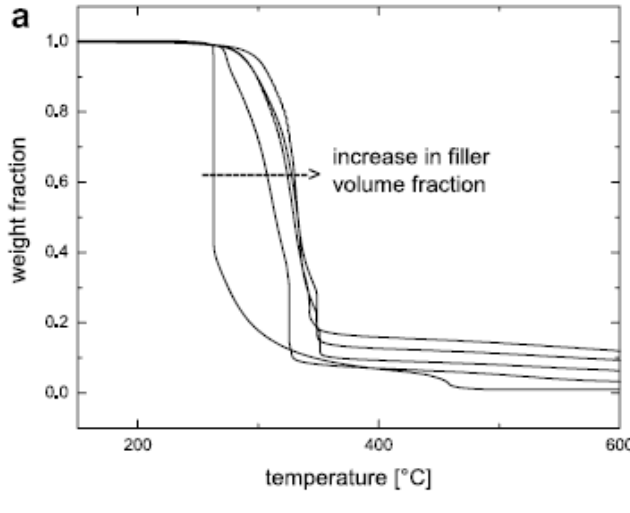
Figure 44. TGA thermograms of the polypropylene nanocomposites as a function of filler volume fraction. Reproduced from reference [50] with permission from